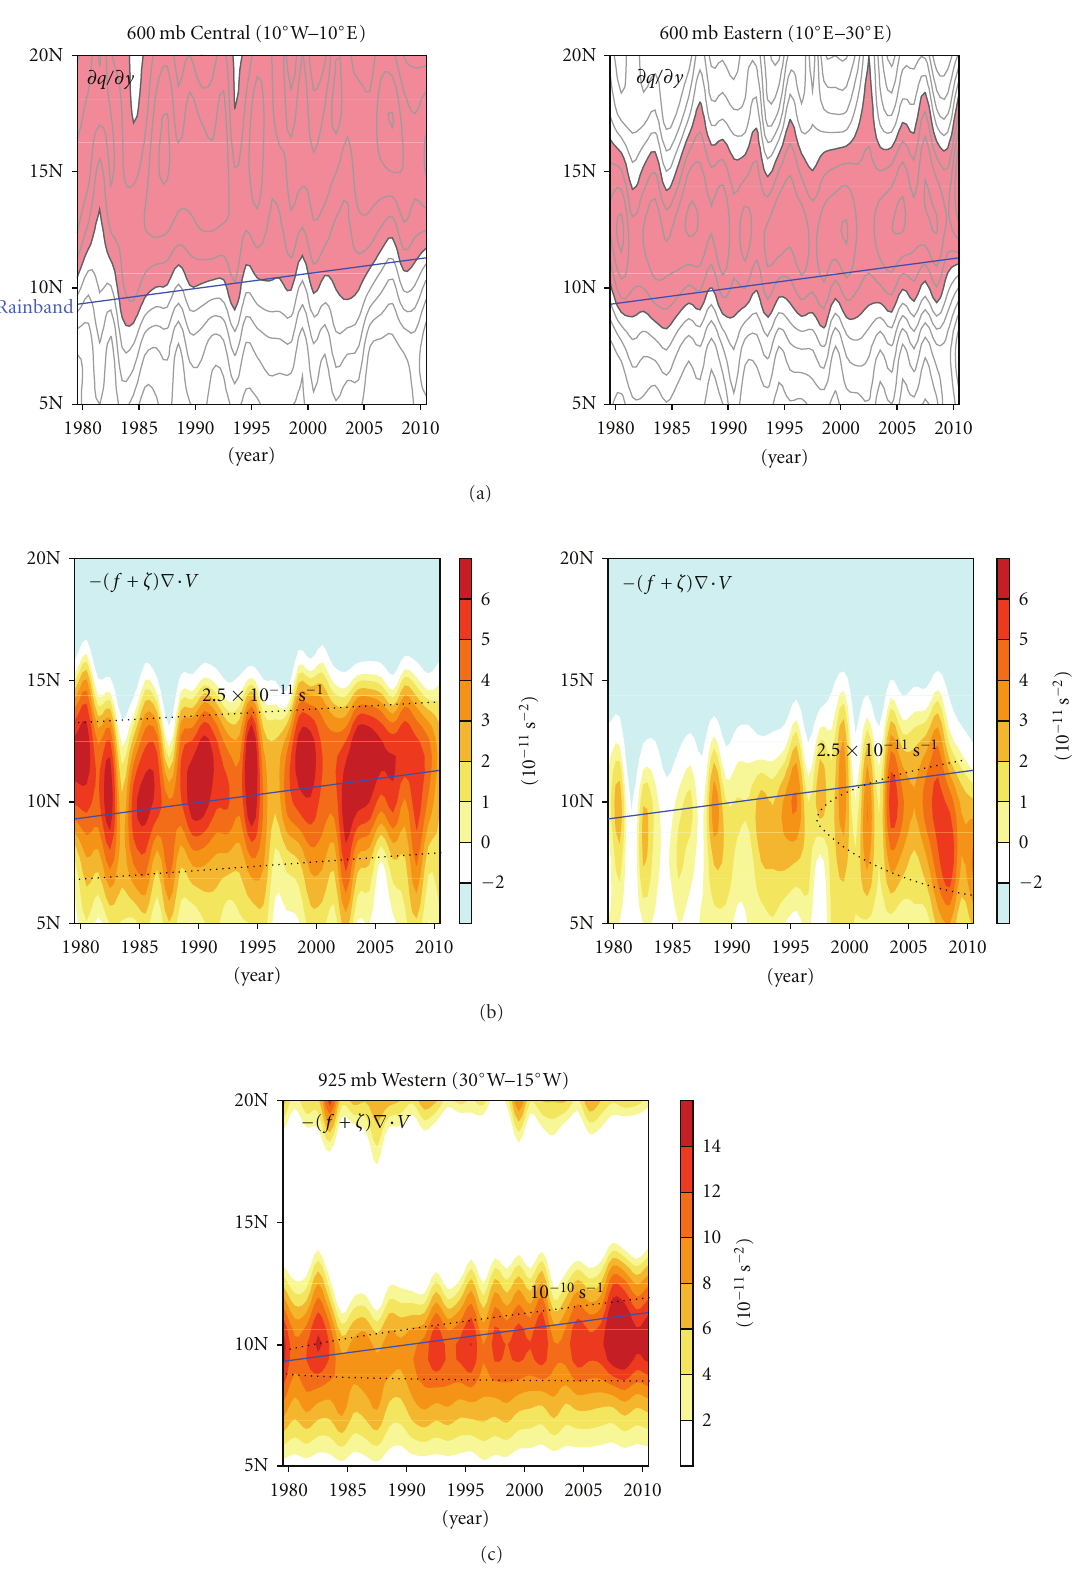
Figure 6: The same as Figure 5 but for (a) meridional gradient of Ertel potential vorticity at 600 mb, (b) vorticity source due to vortex stretching at 600 mb, and (c) vorticity source at 925 mb averaged between 30 ◦ –15 ◦ W. Black dotted lines are linear trends of the designated value. The eastern Sahel conditions are shown in the right with respect to (a) and